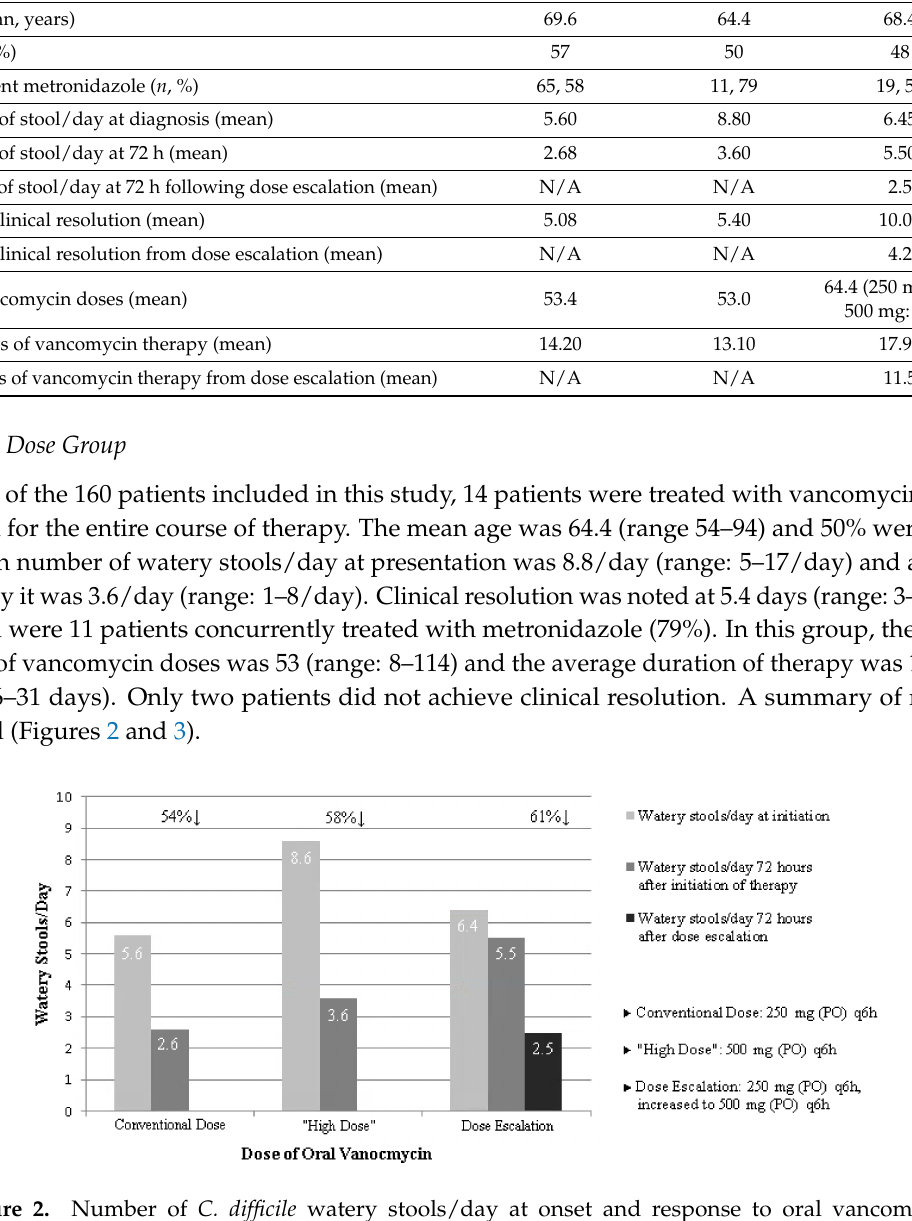
Figure 2. Number of C. difficile watery stools/day at onset and response to oral vancomycin therapy